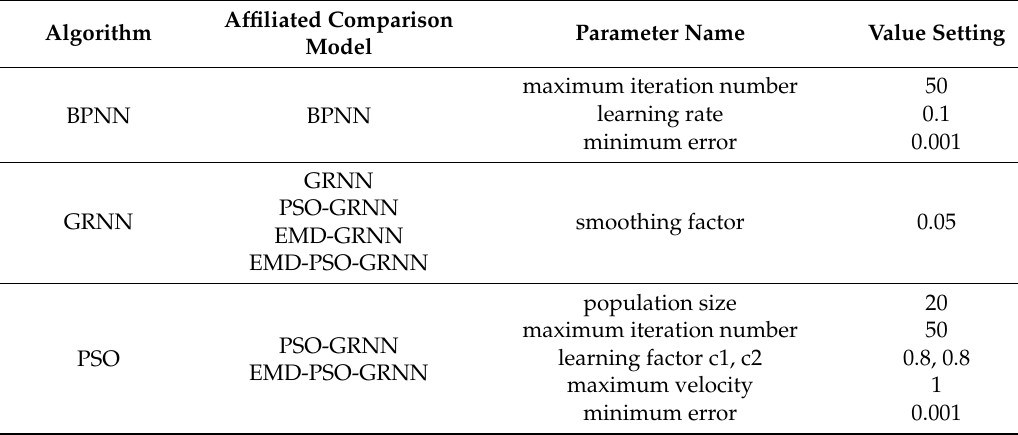
Figure 8. Comparison framework for wind speed forecasting models. ARIMA: autoregressive integrated moving average. Table 2. The parameters settings in each of the comparison